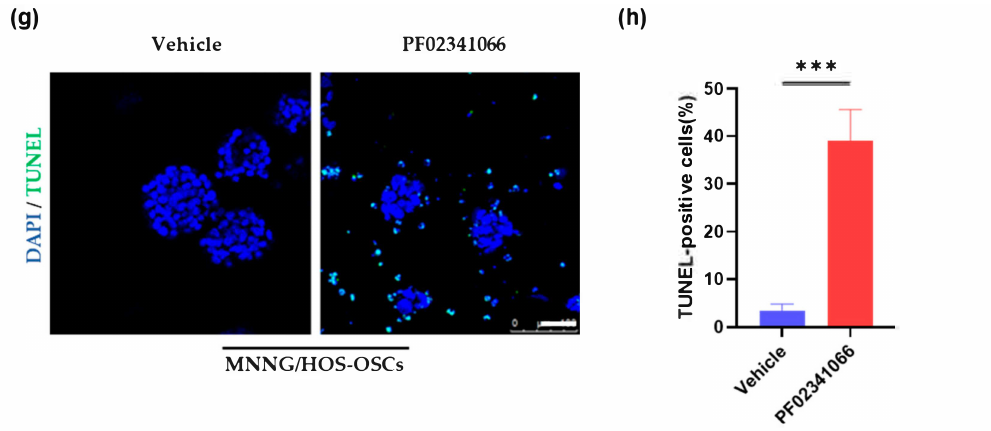
Figure 2. c-Met inhibitor could suppress the proliferation and survival of sensitive MNNG/HOS- OSCs. ( a ) Immunofluorescence staining of MNNG/HOS cells and MNNG/HOS-OSCs with DMSO or 0.05 µ M PF02341066. Scale bar = 50 µ m. ( b ) Western blotting analysis on the protein level of c-Met and its phosphorylation in MMNG/HOS-OSCs with DMSO or 0.05 µ M PF02341066 treatment. Detailed information about Western blot can be found at supplementary materials. ( c , d ) Representative images ( c ) and quantitative analysis ( d ) of soft agar colony formation assay of MNNG/HOS-OSCs treated with DMSO or 0.05 µ M PF02341066. Mean ± SD, n = 3. *** p < 0.001 by two-tailed Student’s t -test. ( e ) Representative bright-field microscopy images showing the MNNG/HOS-OSCs in the serum- free medium after being treated with DMSO or 0.05 µ M PF02341066 for 72 h. Scale bar = 100 µ m. ( f ) Quantitative analysis of crystal violet assay for determining the viability of MNNG/HOS-OSCs after being treated with DMSO or 0.05 µ M PF02341066 for 48 h. Mean ± SD, n = 3. *** p < 0.001 by two-tailed Student’s t -test. ( g ) TUNEL apoptosis staining of MNNG/HOS-OSCs treated with 0.05 µ M PF02341066 for 48 h. TUNEL staining was green and nuclear staining (DAPI) was blue. Scale bar = 50 µ m. ( h ) Quantitative analysis of TUNEL-positive MNNG/HOS-OSCs cells. Mean ± SEM, three independent experiments, each with n = 3. *** p < 0.001 by two-tailed Student’s t